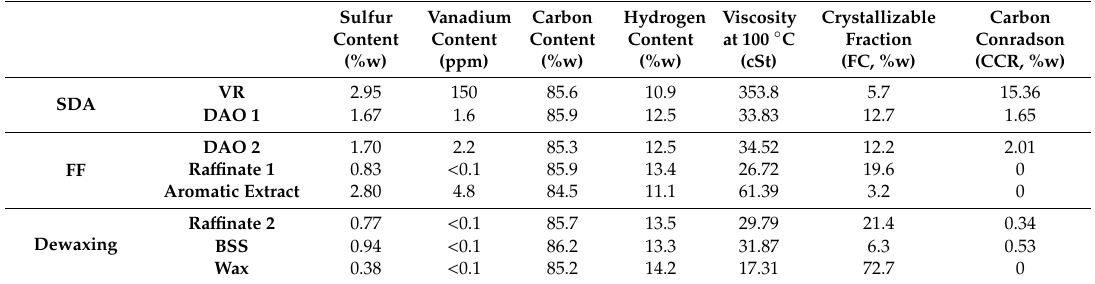
Table 1. Measurable data of di ff erent